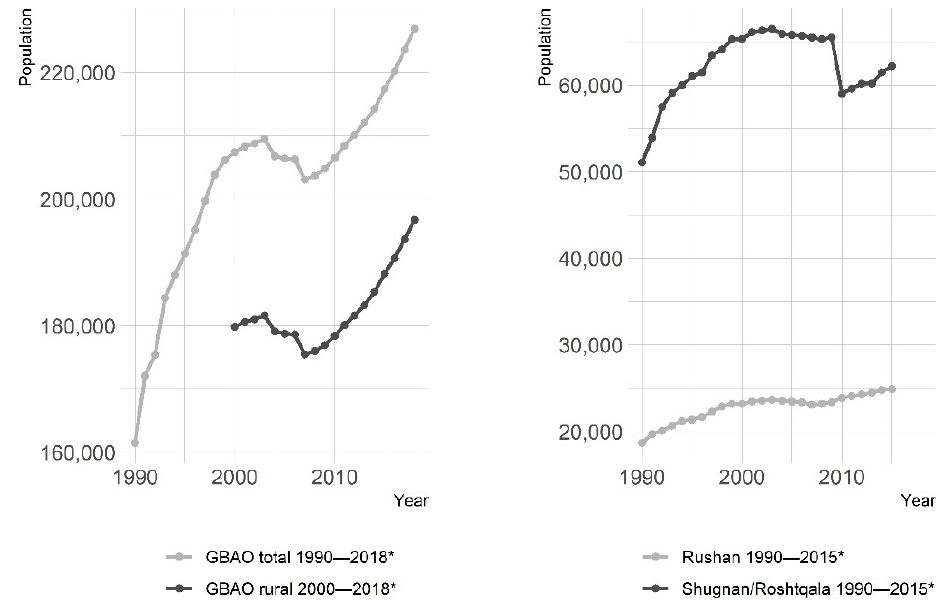
Figure 8. Population time series: the entire province of GBAO (total and rural population, left ) and the districts of Shugnan/Roshtqala and Rushan ( right ; * indicates significant trends, p < 0.01; data sources: [111,112]).